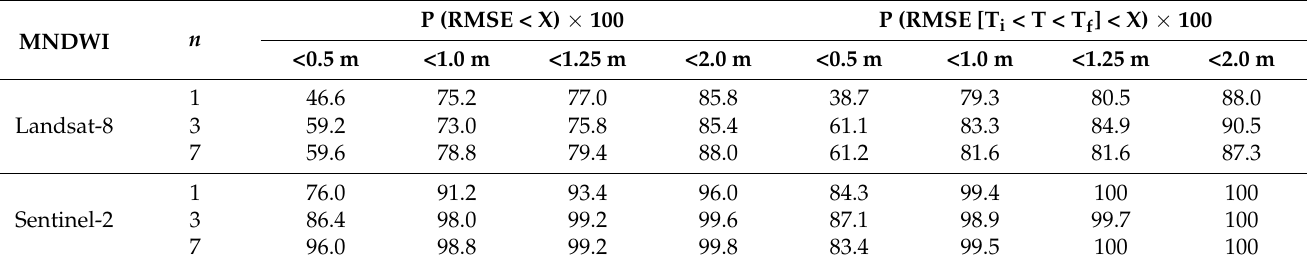
Table 4. RMSE cumulative empirical probability function obtained by mimicked